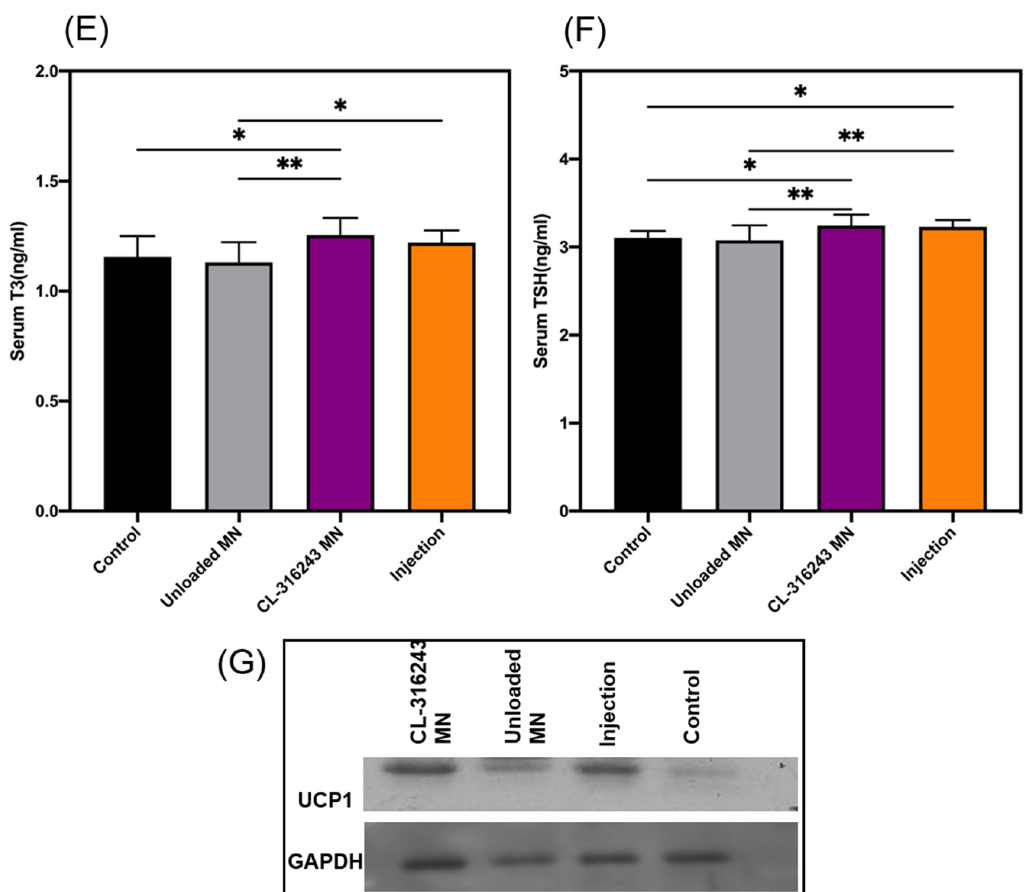
Figure 6. ( A ) BAT weight with different treatments; ( B ) eWAT weight with different treatments; ( C ) iWAT weight with different treatments; ( D ) Representative H&E staining images of WAT (scale bar: 50 μ m) ; T3 ( E ) and TSH ( F ) levels in mouse serum; ( G ) BAT UCP1 protein expression. ( A – C , E , F ) Error bars indicate SD, Ordinary one-way ANVOA test, * p < 0.05, ** p < 0.01 ( n = 15).